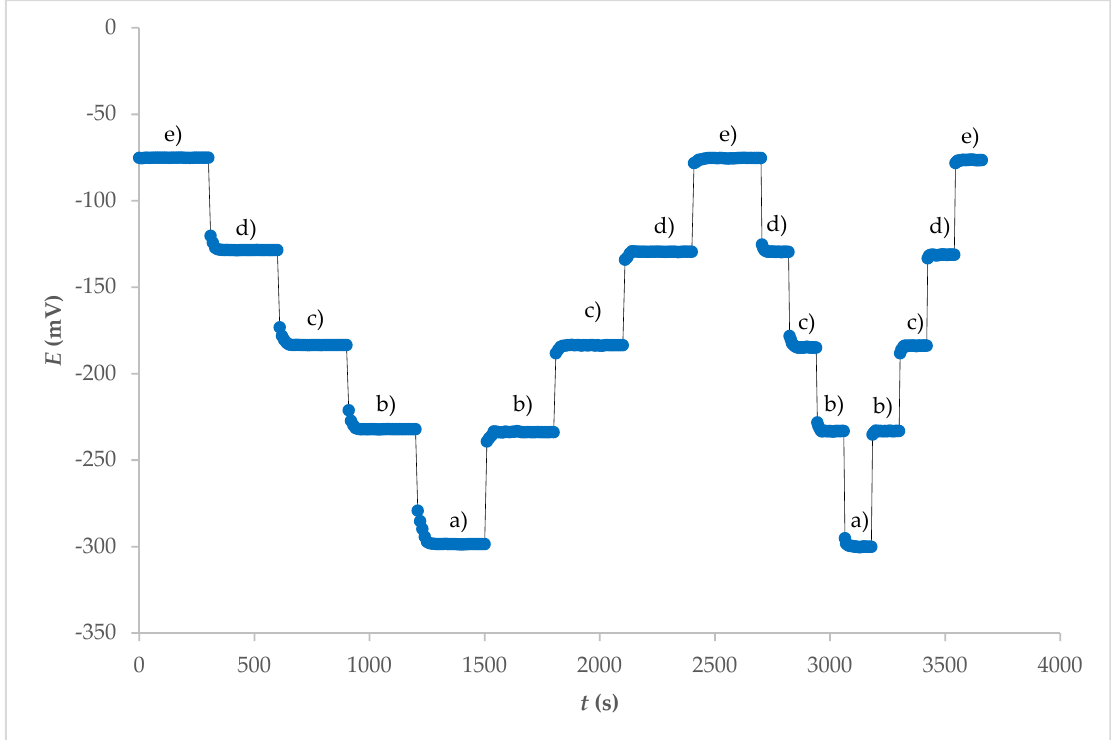
Figure 4. Dynamic response and reproducibility of electrode 7E for different concentrations of F − at pH = 5 after washing Fe x O y NPs out from surface: ( a ) 1 × 10 − 1 M; ( b ) 1 × 10 − 2 M; ( c ) 1 × 10 − 3 M; ( d ) 1 × 10 − 4 M; ( e ) 1 × 10 − 5 M.